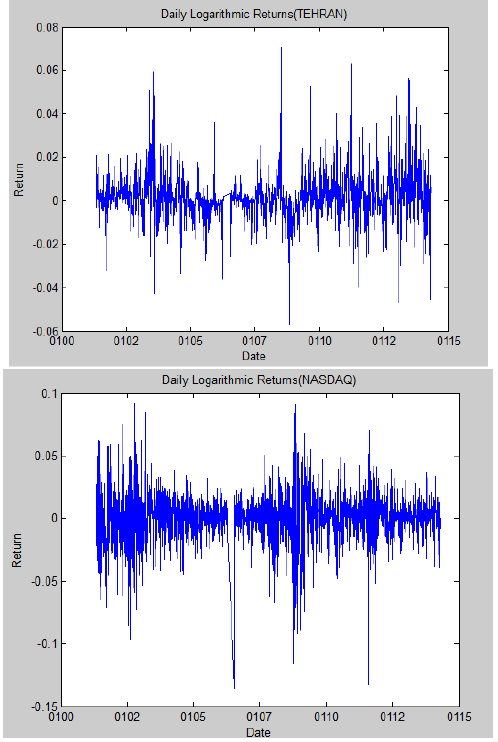
Fig. 2. Daily returns of TEPIX and